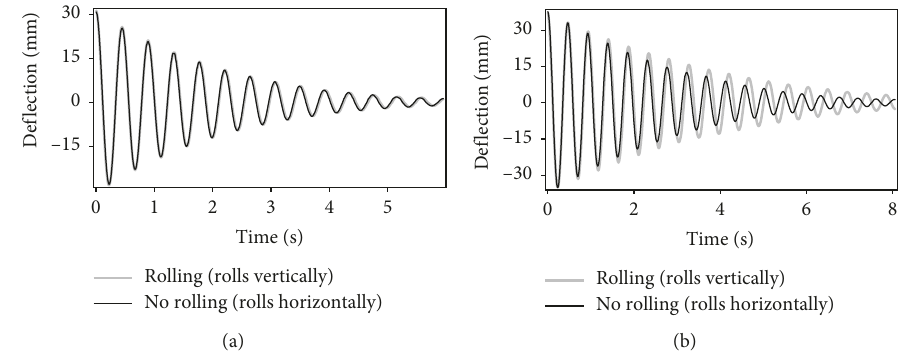
Figure 17: The effect of alignment of the magnets for the thick (6mm (a)) and thin (4mm (b)) structure, MRE 1B, magnets M15.